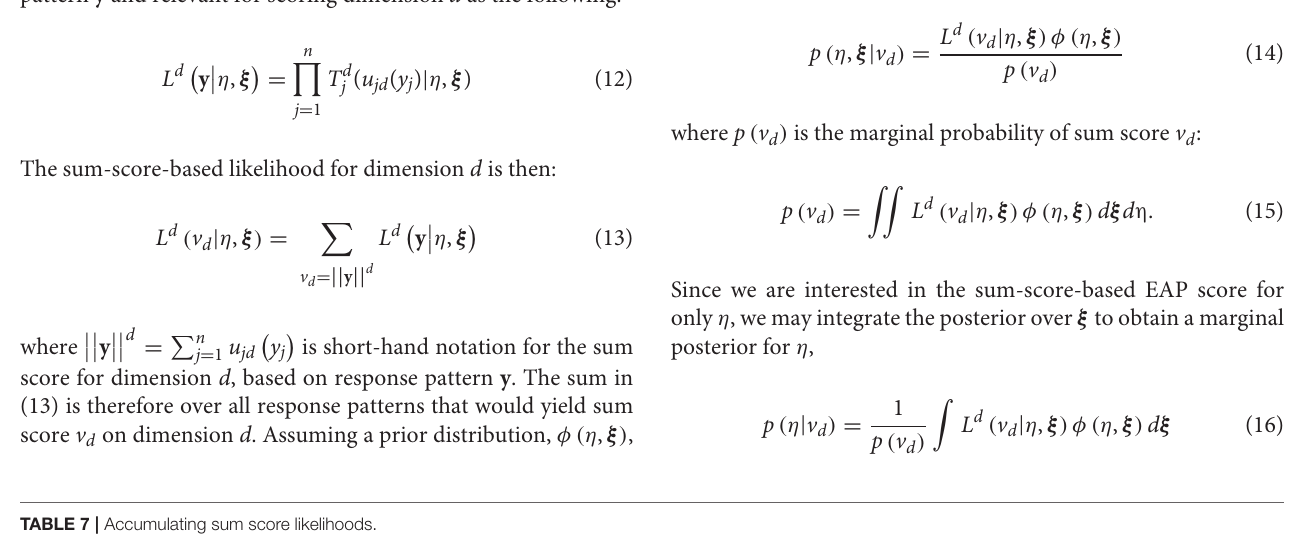
Quadrature grid for ( η , ξ )